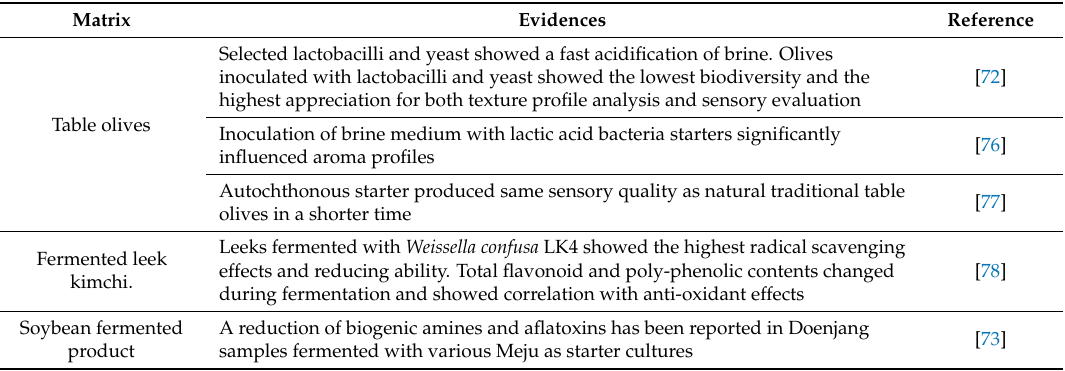
Table 6. Selected scientific evidences concerning the effect of starter cultures inoculation in comparison with spontaneous fermentation.